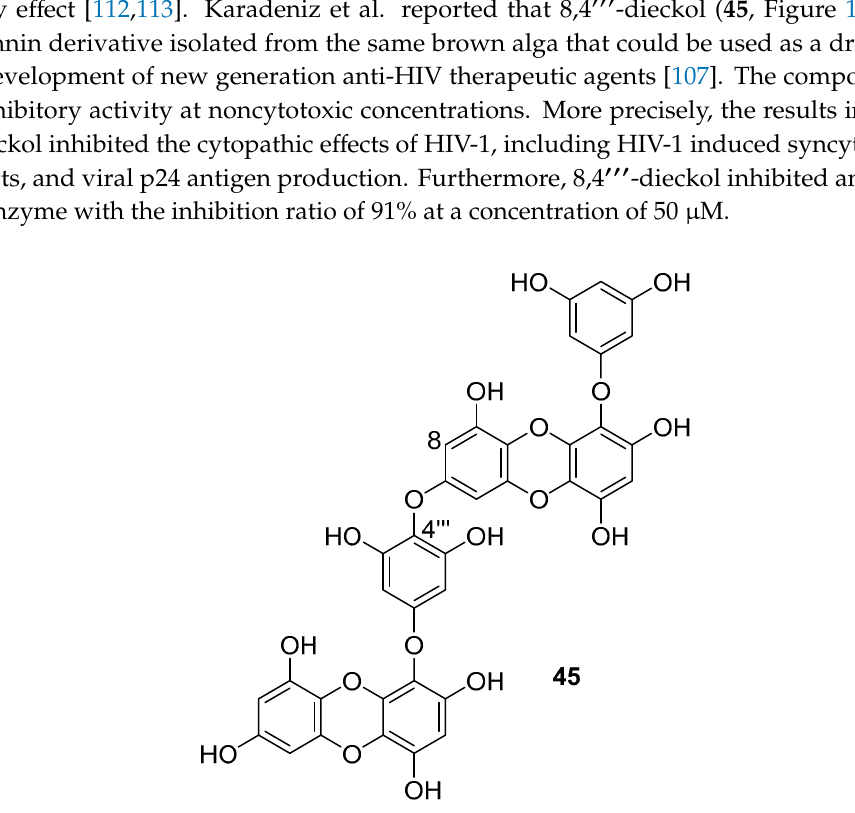
Figure 19. Chemical structure of 8,4 ′′′ -dieckol ( 45 ) from E. cava .